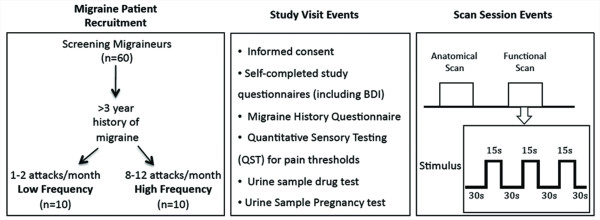
Subject Recruitment and Experimental Approach. Based on the frequency of migraine attacks per month, Low frequency (LF) and High frequency (HF) episodic migraine patients were recruited to the study. During the study visit Quantitative Sensory Testing (QST) for pain threshold was performed for each subject and questionnaires were filled out. For each subject morphological (as part of the anatomical scan) and functional (evoked to thermal stimuli) images were acquired as shown in the diagram. Thermal stimuli paradigm is also shown in the diagram.